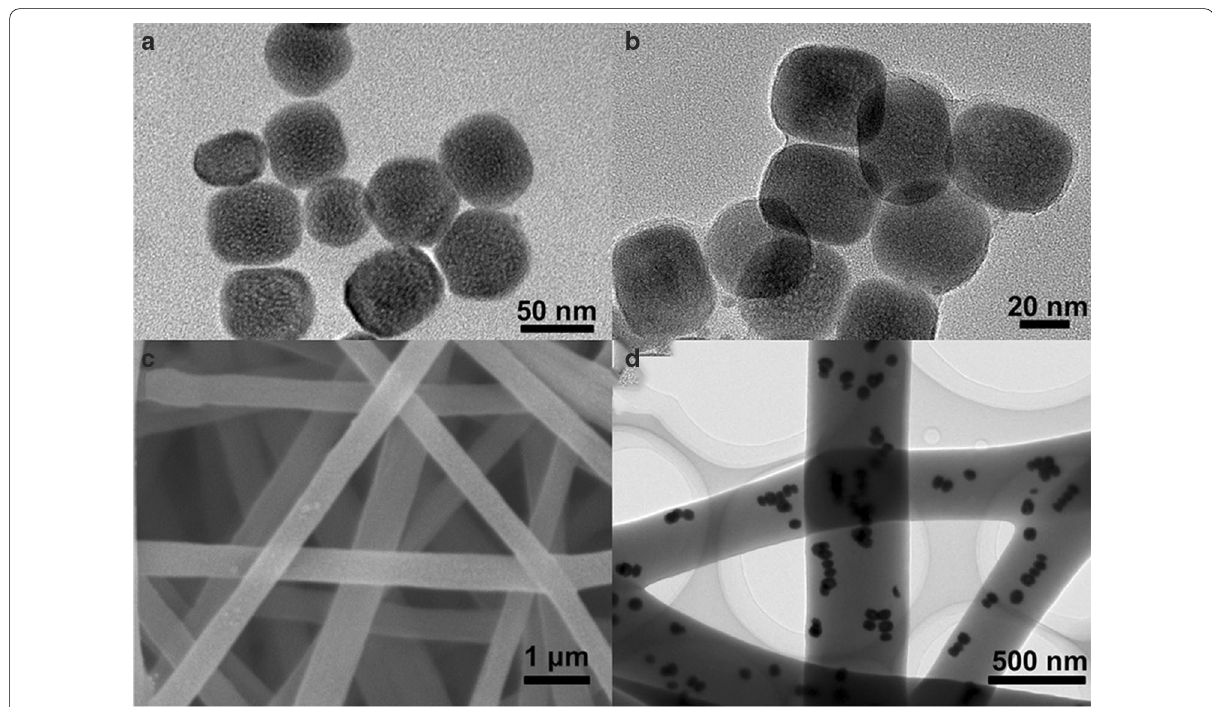
Fig. 1 TEM images of a NaYF 4 :Yb/Tm@NaYF 4 :Nd nanoparticles (UCNPs) and b core–shell structured UCNPs@Curcumin nanoparticles. c SEM image of curcumin composite nanofibers, d TEM image of curcumin composite